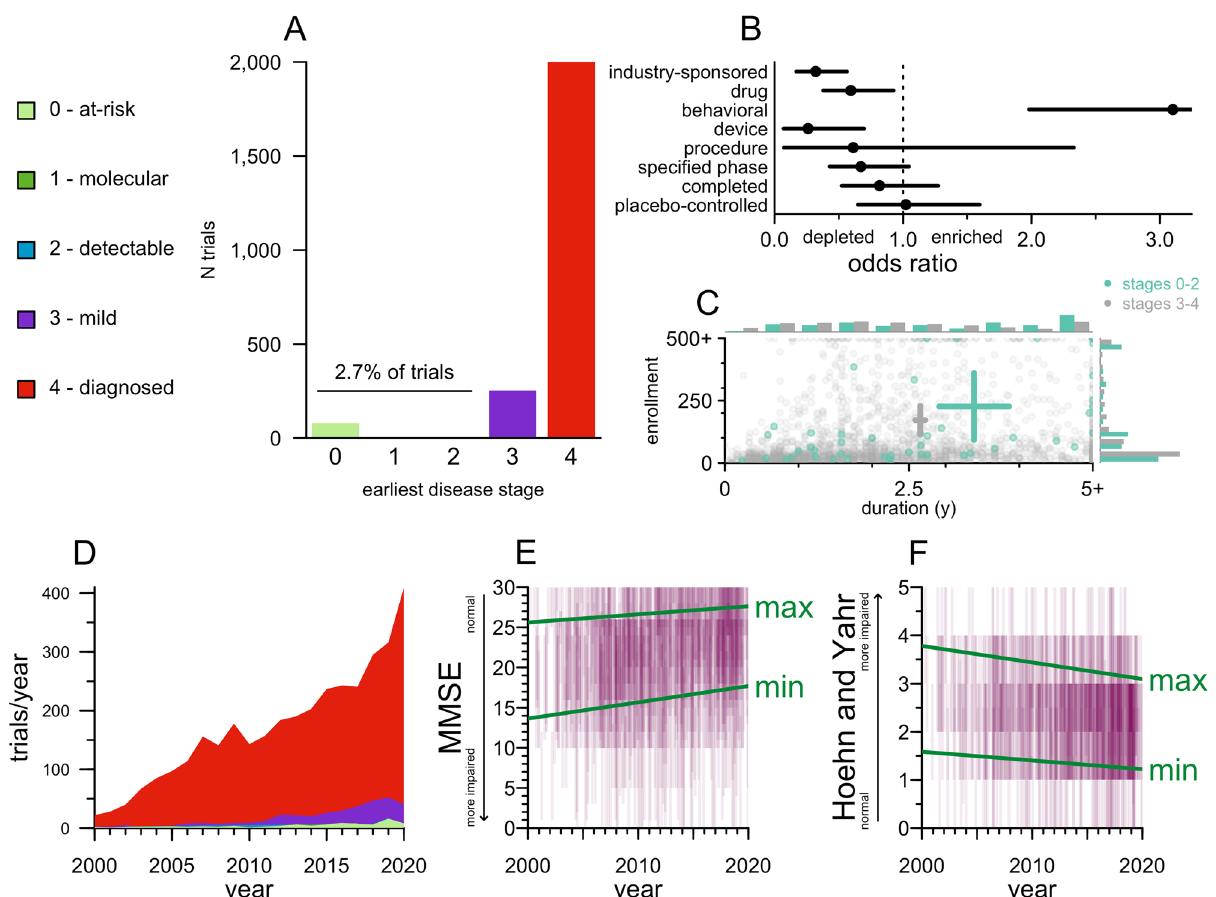
Figure 3. Disease stages eligible for trials. ( A ) Barplot of trial count by earliest disease stage (legend at left, see Methods for details) eligible to enroll. ( B ) Forest plot of odds ratios (Fisher’s exact test) for properties of preventive (stage 0–2) versus symptomatic (stage 3–4) trials. ( C ) Scatterplot of study duration (x axis) and enrollment (y axis) for preventive (stage 0–2, cyan) versus symptomatic (stages 3–4, gray) trials, with marginal histograms on both axes. Crosshairs represent mean and 95% confidence intervals of the mean on both dimensions. ( D ) Stacked area plot of the number of trials per year by earliest eligible disease stage. For 2020, only 3 months of data were included, so the raw number of trials was scaled by a factor of 4 to yield trials/ year. ( E ) Eligible MMSE score ranges by year, N = 911. Each trial is displayed as a purple rectangle of 10% transparency stretching from the lowest to highest eligible score on the y axis and staggered by ± 0.5 years on the x axis, such that darker shades of purple indicate a greater density of trials recruiting patients in a given score range in a given year. Green lines represent best fits from linear regression models. Lower scores indicate greater impairment. ( F ) As in ( E ), but for Hoehn and Yahr, N = 757; note that on this scale, higher scores indicate greater